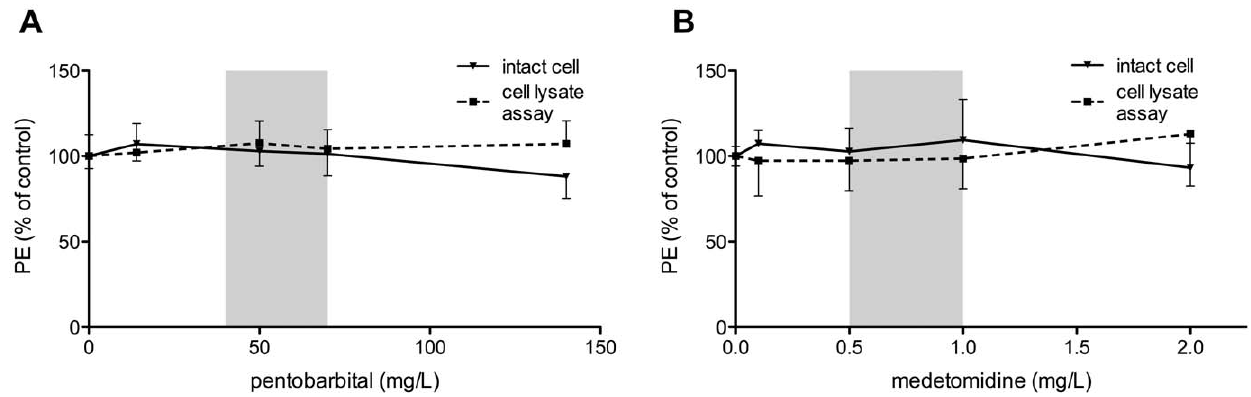
Figure 3. Effect of pentobarbital and medetomidine on BLI signal of intact cells and cell lysates. The effect on photon emission (PE) of the anesthetics pentobarbital ( A ) and medetomidine ( B ) are shown using intact cells (full line) and cell lysates (dotted line). All data are represented as mean % of control (absence of anesthetic) 6 SD. Grey intervals in the curves indicate the concentrations used in vivo , as reported in literature for